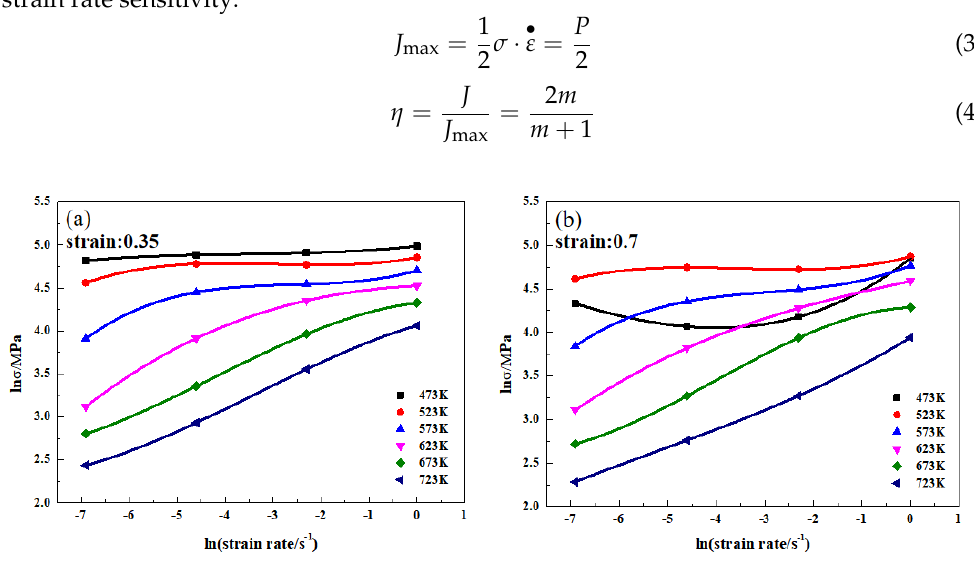
• ε ln with strains of ( a )